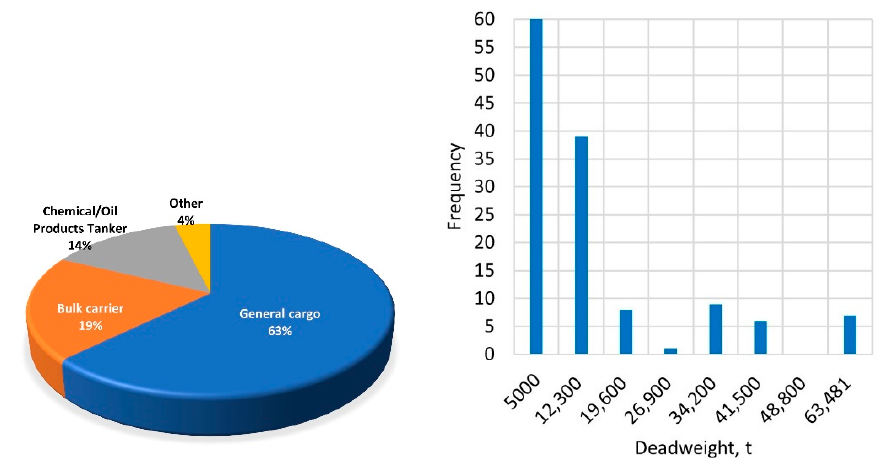
Figure 2. Types ( left ) and DW ( right ) of queuing ships.